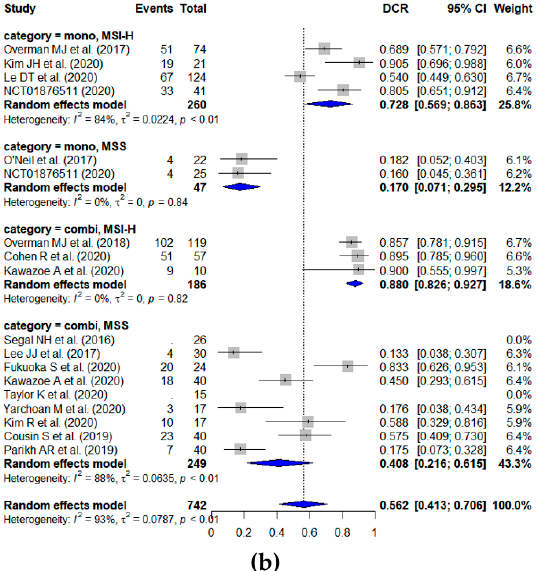
Figure 5. Forest plots of the ( a ) pooled ORR and ( b ) DCR of each subgroup according to the microsatellite phenotype and drug regimen in patients treated with ICIs as second- or more-line therapy.